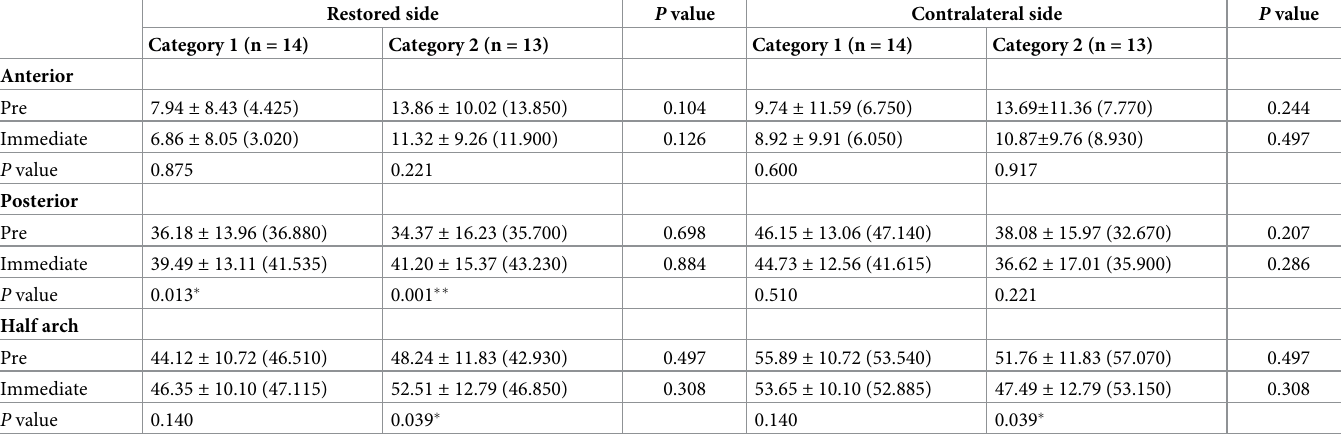
Table 4. Comparison of the bite force distribution on segments (before treatment vs immediately following restoration).